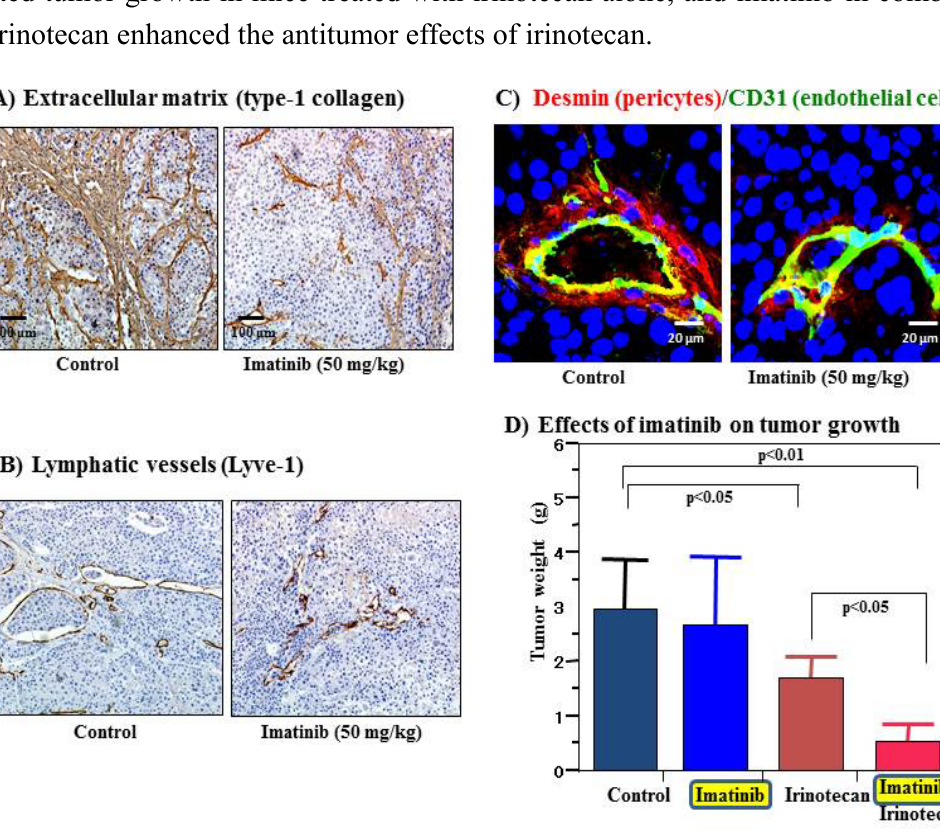
Figure 2. Effects of imatinib on extracellular matrix (ECM), lymphatic vessels, and pericytes. ( A , B ) Immunohistochemical detection of type-1 collagen ( A ) and lyve-1 in TMK-1 orthotopic tumors was carried out by the linked streptavidin-biotin method. ( C ) Morphology and distribution of pericytes (as shown by red fluorescence)